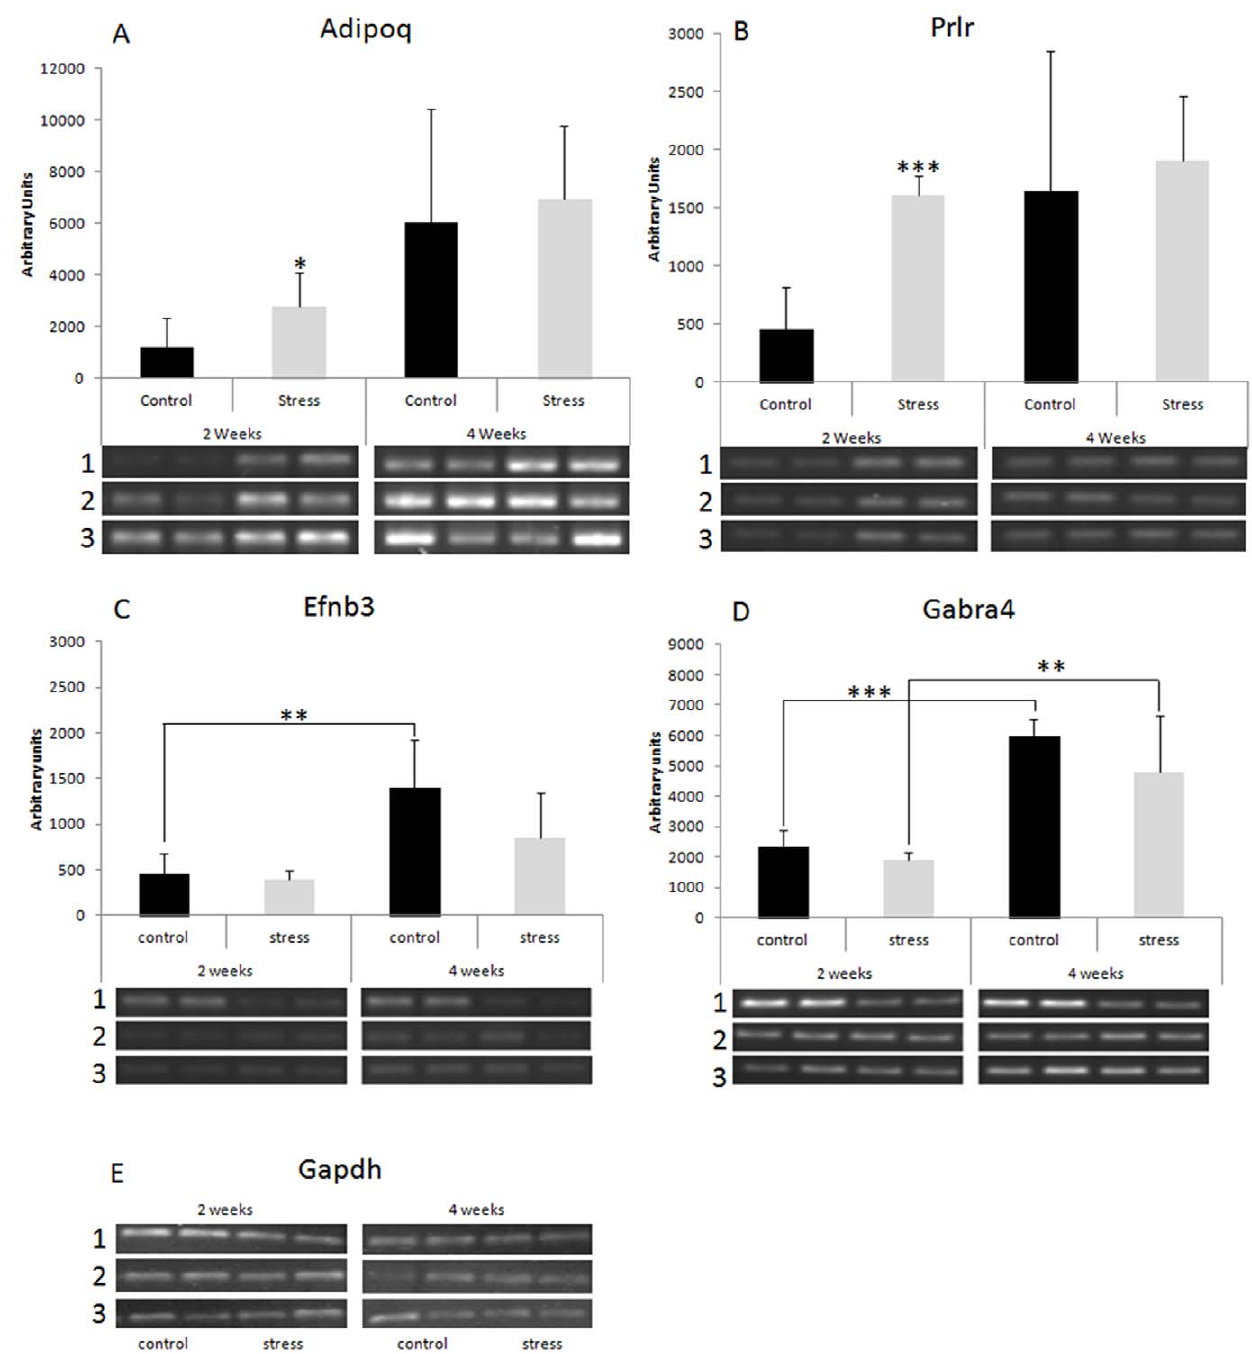
Figure 5. sq-RT-PCR analysis. A: prolactin receptor ( Prlr ) gene; B: Adipoq gene. C: ephrin B3 receptor ( Efnb3 ) gene; D: GABA (A) receptor 4 ( Gabra4 ) gene. E: GAPDH. Data are represented as an average of three animals per group. Asterisks represent statistical significance (* p , 0.05; ** p , 0.01; *** p , 0.001). Error bars represent standard deviation of the mean. Photographs below bars represent corresponding PCR fragments in duplicates for each animal for three animals per